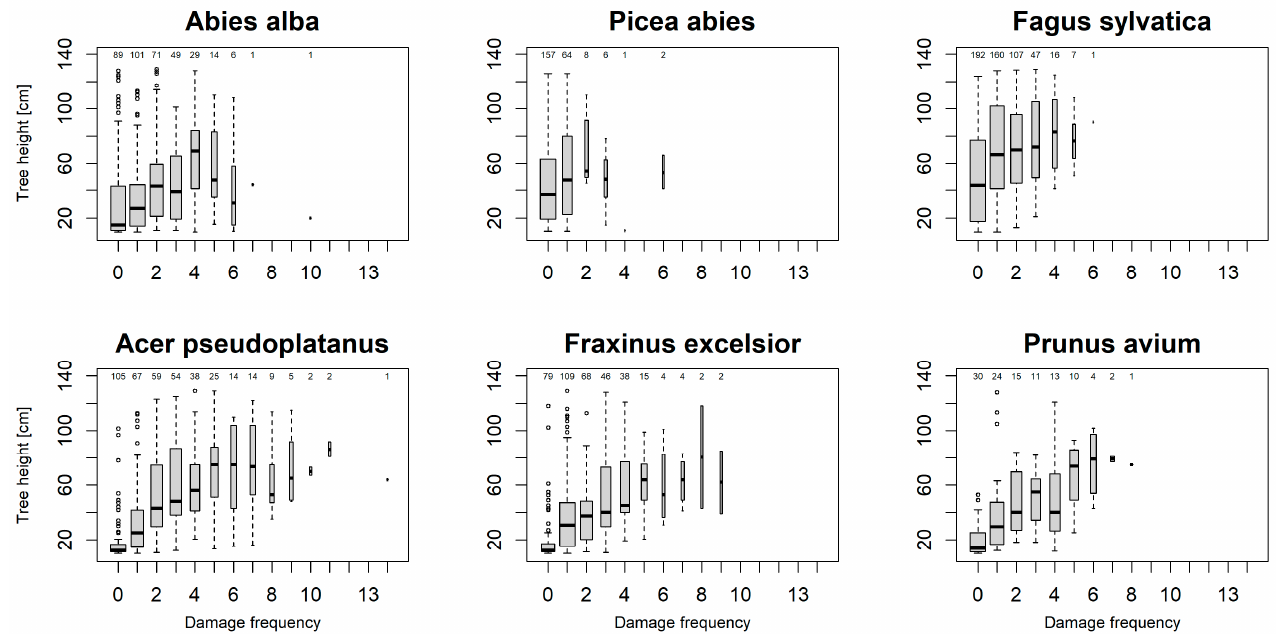
Figure 6. Frequency of damage along the main stem axis for the six main tree species. The numbers displayed in all panels indicate the number of saplings sampled with the respective damage frequency. For details about the box plot, see Figure 4.